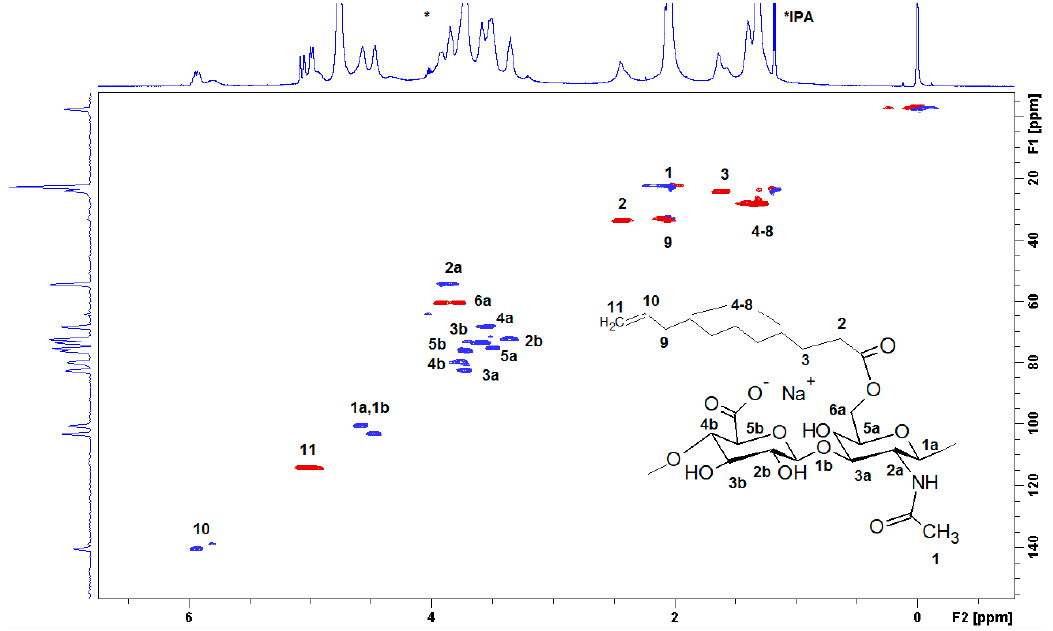
Figure 3. The heteronuclear single quantum correlation (HSQC) spectrum of HA-UDA (15,000 g / mol, DS = 35.4%) recorded in D 2 O. The spectrum was acquired at a concentration of 10 mg · mL − 1.